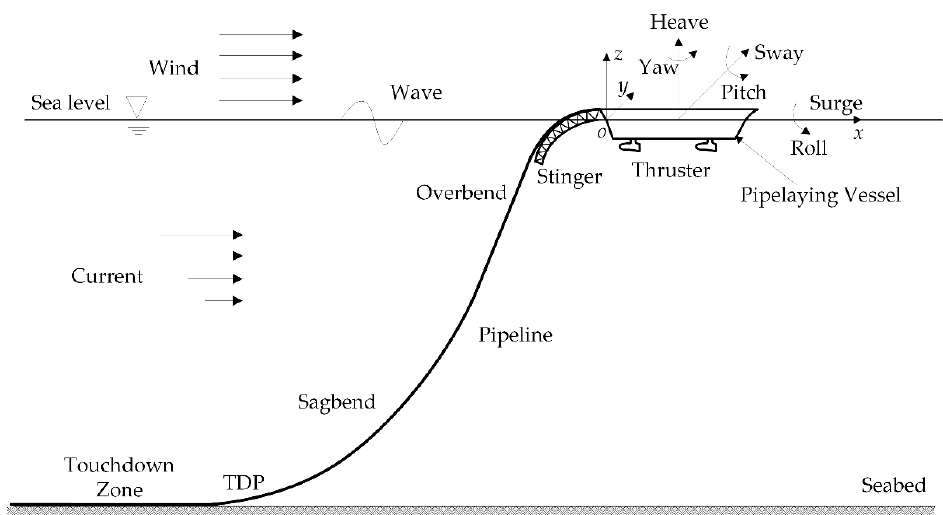
Figure 1. Schematic diagram of S-laying pipeline installation.